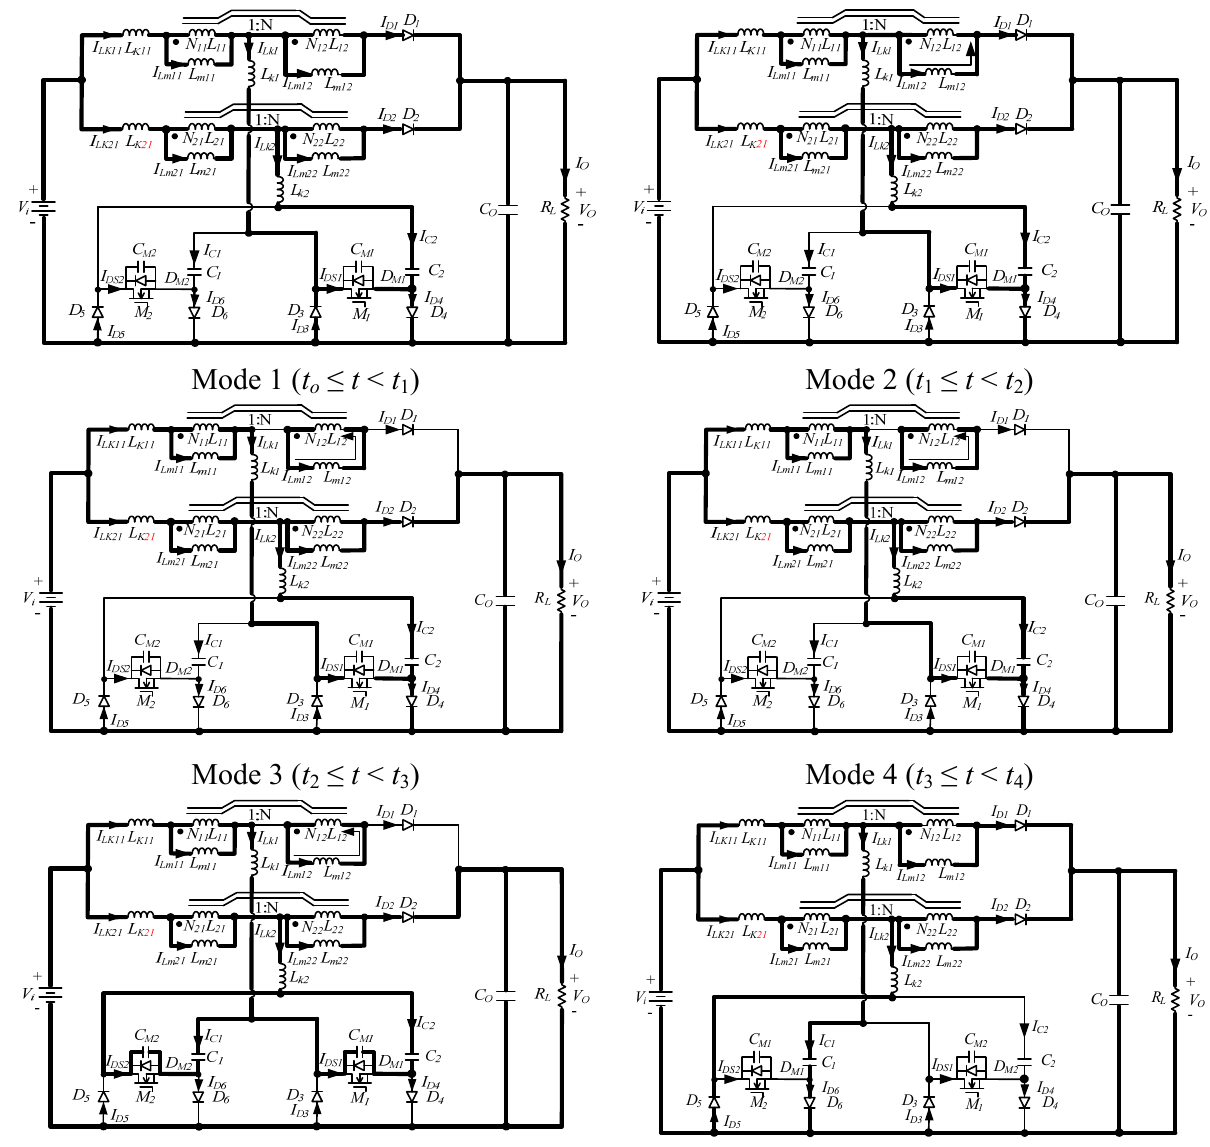
Figure 11. Equivalent circuit of each operational mode in the proposed interleaved active clamp boost converter with coupled inductor over half of one switching